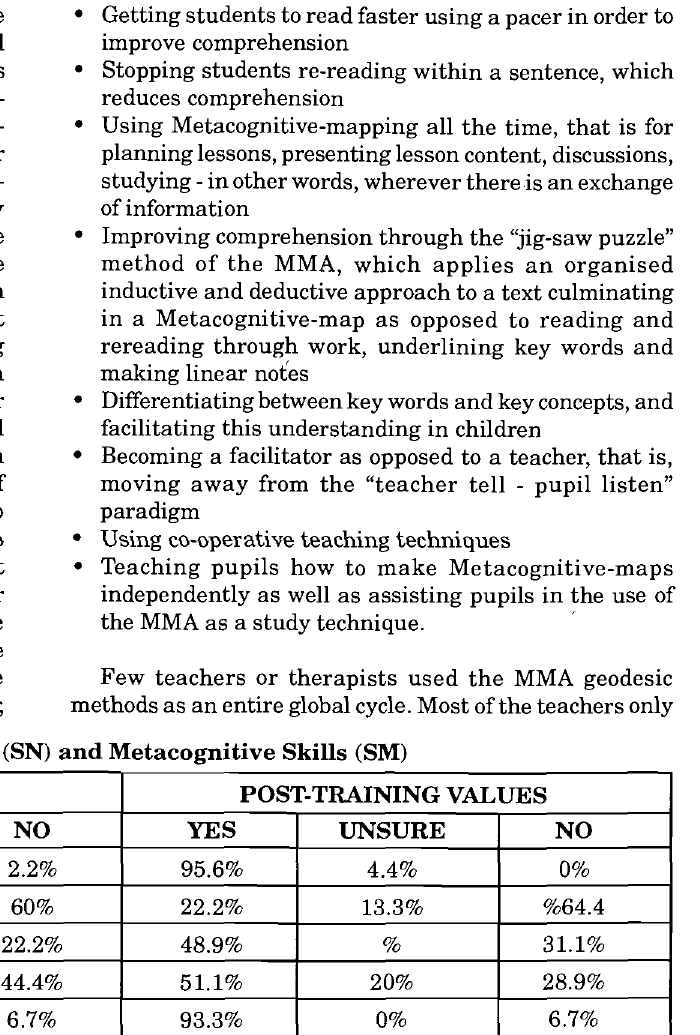
I PRE-TRAINING VALUES